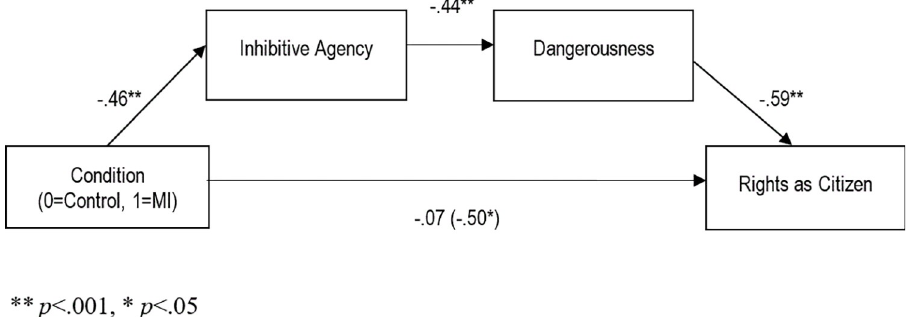
Fig 3. Indirect effect model of using the defense of mental impairment on rights as citizen, via inhibitive agency and dangerousness. Path values are expressed in unstandardized coefficients.